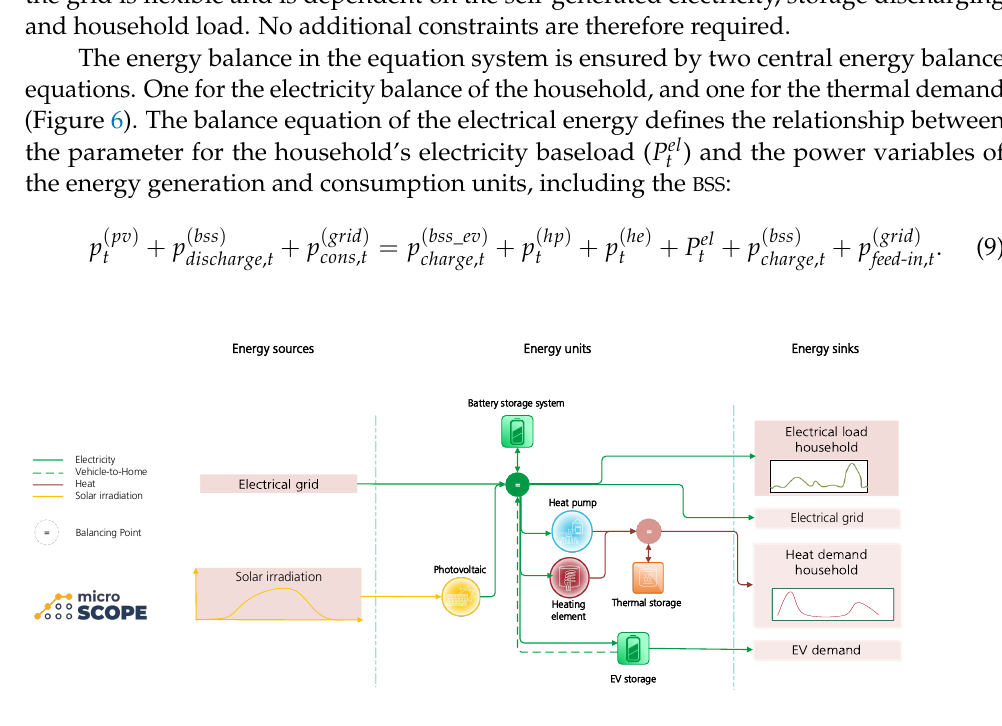
Figure 6. Visualization of the modelled microsystem with all possible power